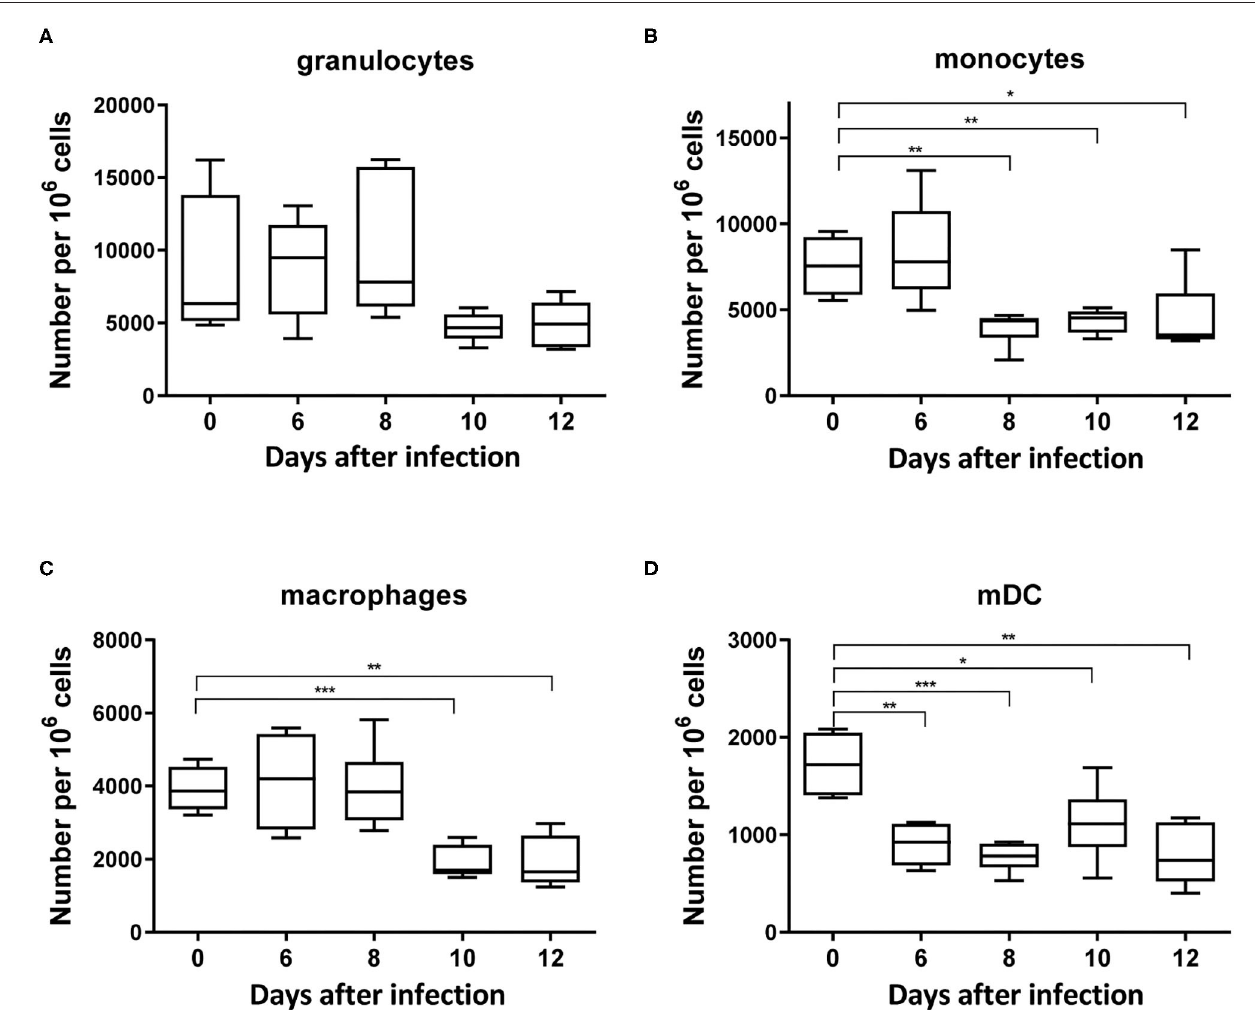
FIGURE 1 | Frequencies of myeloid subpopulations during acute FV infection in the spleen. C57BL/6 mice were infected with FV and splenocytes were isolated at different time points after infection. Multi-parameter flow cytometry analysis was used to determine the numbers of granulocytes (CD11b + Ly6C low Ly6G high ) (A) , monocytes (CD11b + Ly6C high Ly6G low ) (B) , macrophages (CD11b + Ly6G − Ly6C − F4/80 + CD11c low ) (C) , and mDC (CD11b + Ly6C − Ly6G − CD11c + ) (D) per one million of nucleated cells in the spleen at different time points after infection. Each bar represents the mean number plus SEM per one million nucleated cells for a group of 5–9 mice. Data were pooled from three independent experiments with similar results. Differences between naïve (day 0) and 6, 8, 10, and 12 days infected mice were analyzed using one-way ANOVA with a Tukey post-test (* p < 0.05, ** p < 0.005, *** p <